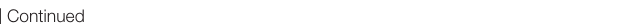
FIGURE 4 | Continued Visualization of structural details and alignment of the two structures (cyan overlapping red) were performed by PyMOL software. The RMSD value between the predicted SARS-CoV-2 nsp1 13 - 127 and SARS-CoV nsp1 13 - 127 structures is 0.087 Å. The organization of the main secondary structures is indicated in a selected rotation. (B) Solid surface views of the SARS-CoV nsp1 13 - 127 and predicted SARS-CoV-2 nsp1 13 - 127 structures. These models have the same orientations as in panel (A) . Red represents negatively charged; blue represents positively charged. Some key surface residues in the large areas of negative or positive charges are indicated. (C) Solvent-exposed residues of SARS-CoV and SARS-CoV-2 nsp1 proteins are highlighted in green. Those in boldface represent a few differences between SARS-CoV and SARS-CoV-2 nsp1. (D) Comparison of aa sequences and secondary elements between SARS-CoV and SARS-CoV-2 nsp1. Sequence alignment was conducted using Clustal X and visualized by ESPript. The main secondary structures of SARS-CoV and SARS-CoV-2 nsp1 are displayed above and below the sequences, respectively. The secondary structures of SARS-CoV-2 were predicted by SWISS-MODEL server as described in panel (A) . Note that some predicted secondary structures exhibit subtle differences with those analyzed in PyMOL. Several aa sites discussed in the text were indicated with arrowheads. Two regions involved in the studies of attenuated vaccines were underlined with red dashed